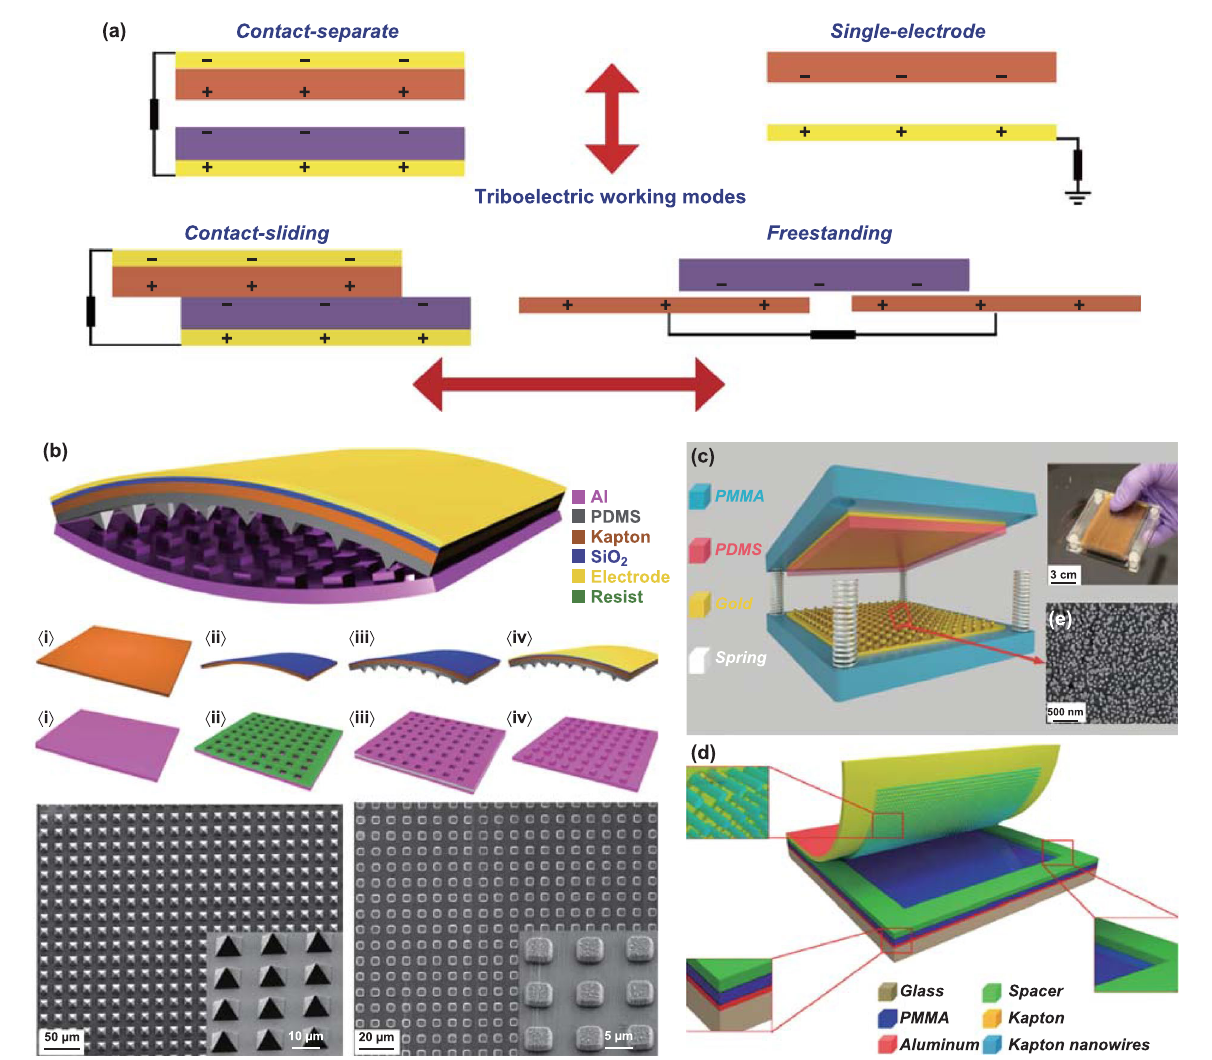
Fig. 1 The main modes of triboelectric nanogenerators (TENGs) and examples of construction: a four main working modes, and b example of the surface modification of the polymer‑based TENG. Reprinted with permission from Ref. [30]. Copyright (2012) American Chemical Society. c Example of construction of a TENG operating under the contact‑separation mode using springs. Adapted with permission from Ref. [36]. Copyright (2013) American Chemical Society. d Schematic illustration of the polymer TENG operating under the contact‑separation mode